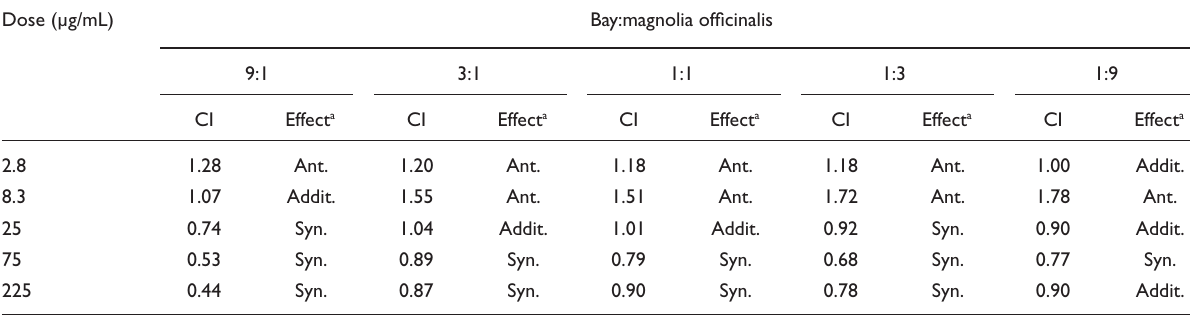
Table 6. The interaction between bay and magnolia officinalis against tyrosinase Dose